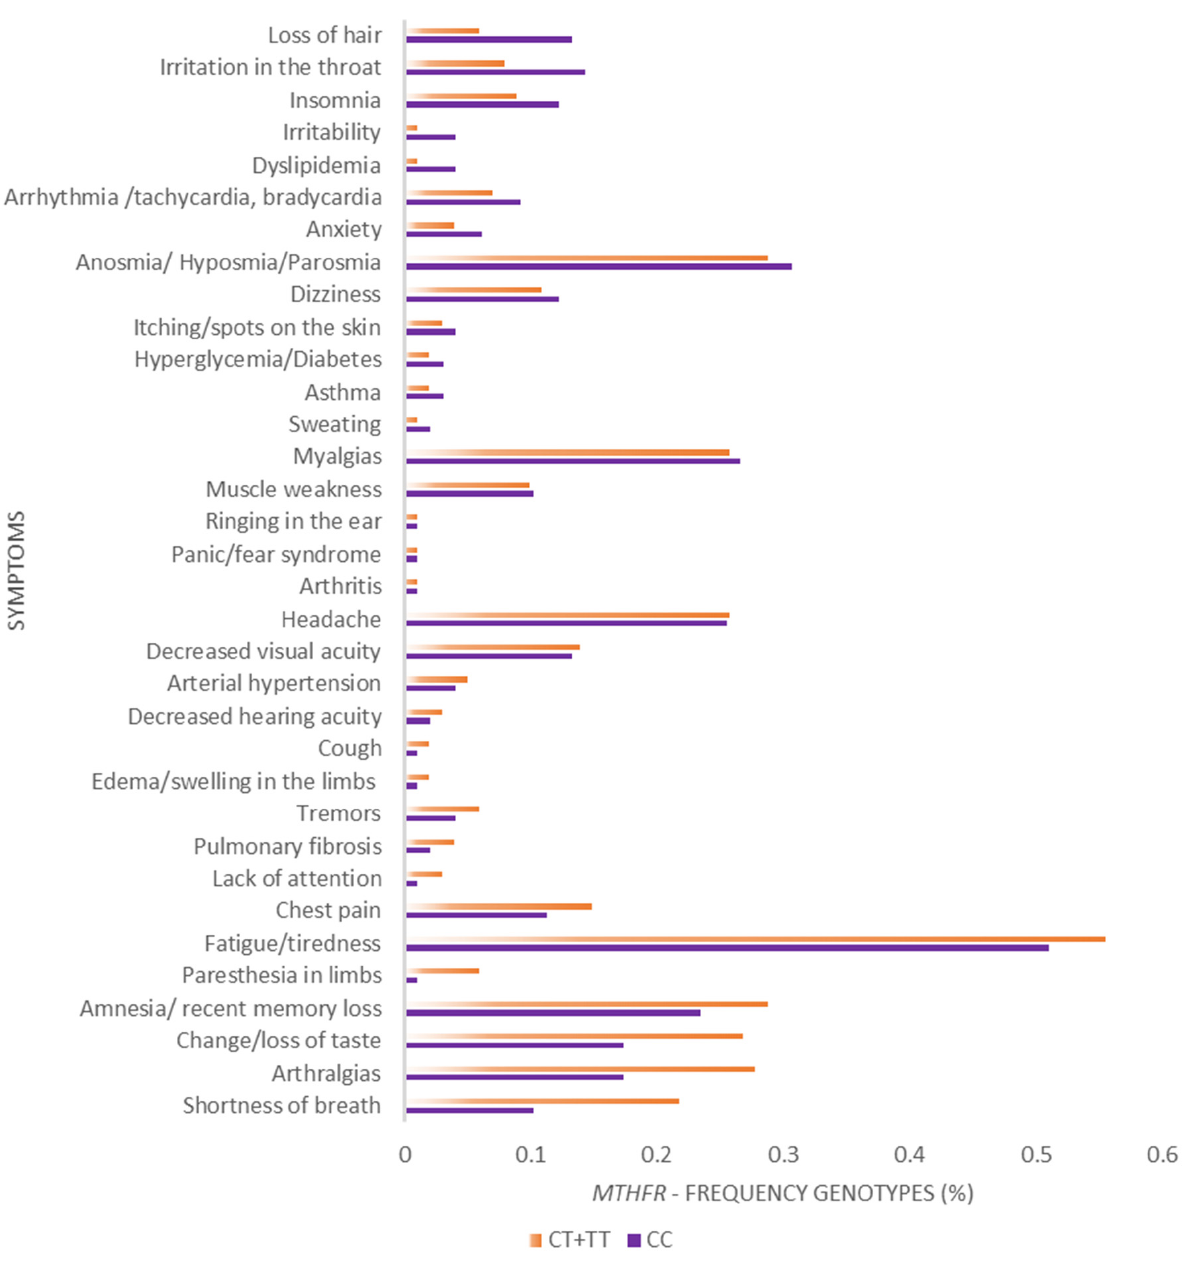
Figure 3. Comparison of Frequencies of the main symptoms (%) during long COVID among MTHFR CC and CT+TT genotype carriers (Paired Wilcoxon test: Z = 0.31, p = 0.7489).